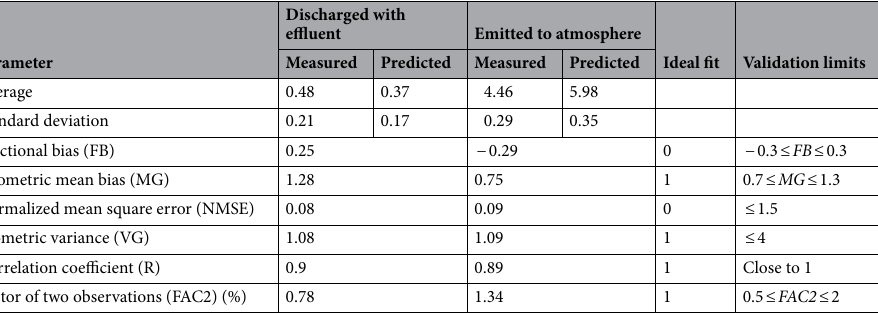
Table 3. Statistical parameters of data validation of H 2 S emitted to atmosphere and discharged with